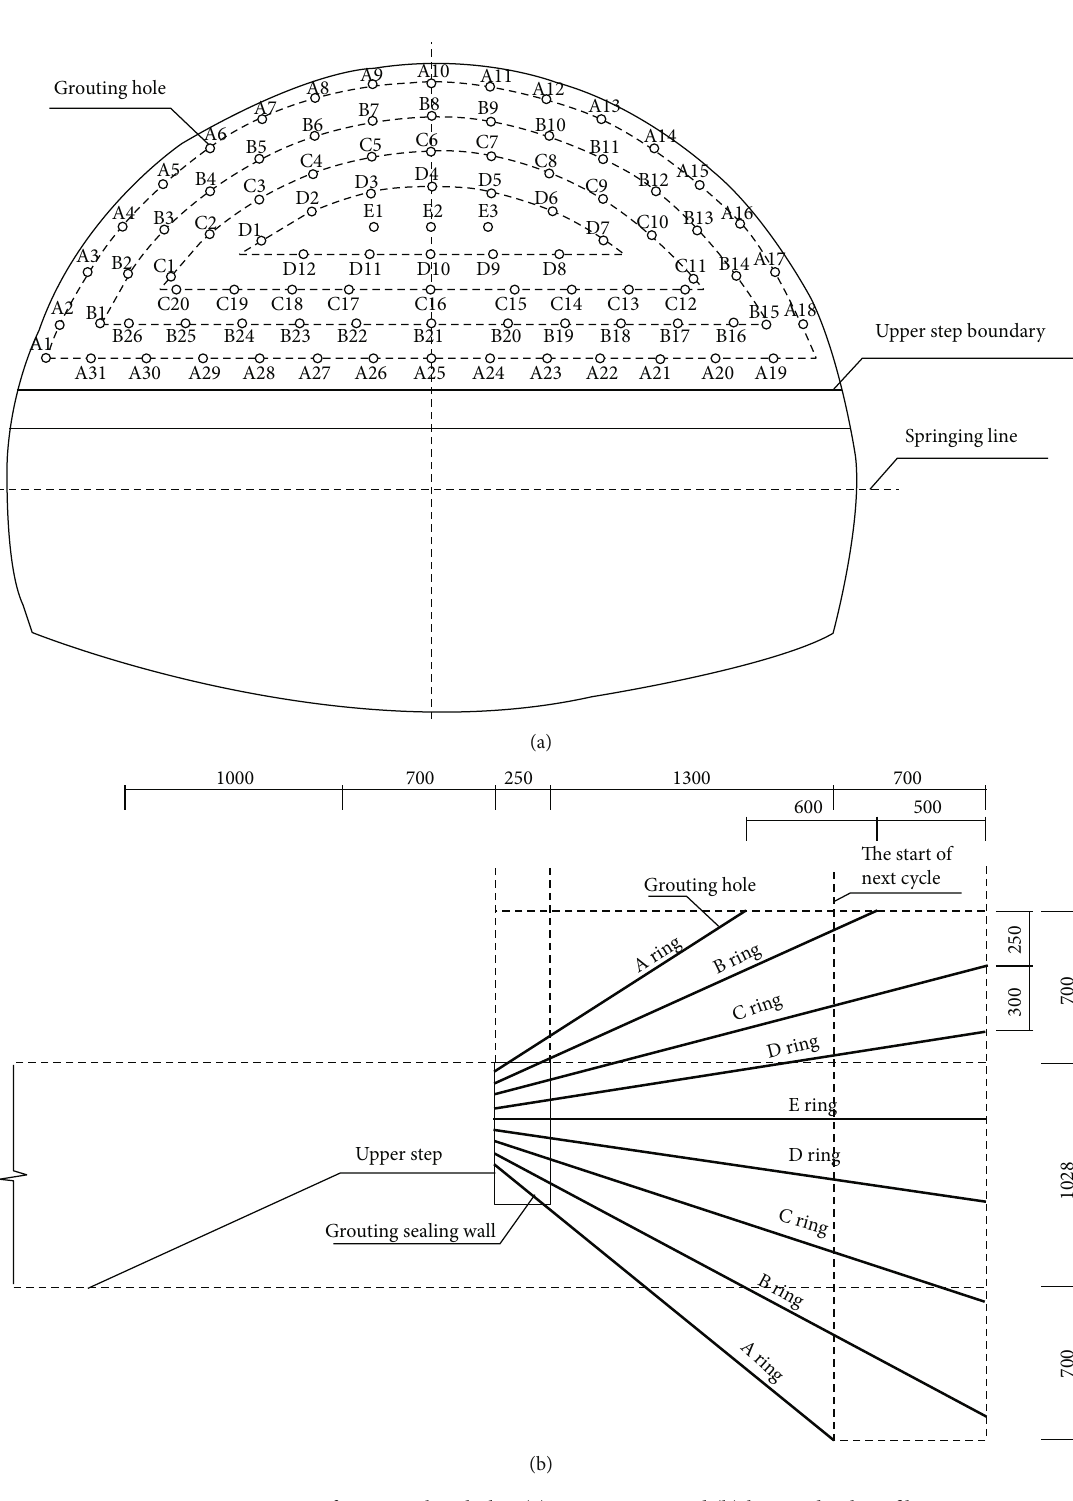
Figure 5: Layout of grouting boreholes: (a) cross section and (b) longitudinal pro fi